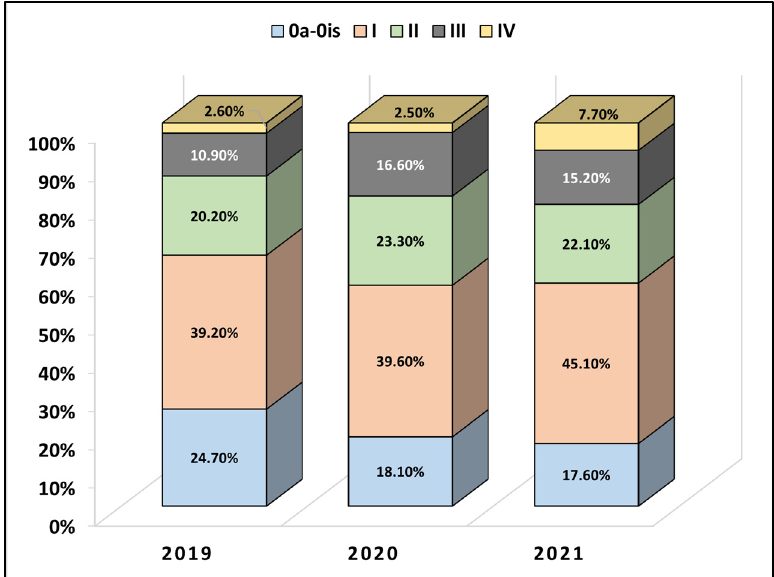
Figure 2. Comparative analysis of the TNM staging of urothelial carcinoma in patients receiving surgery before (2019) and during the SARS-CoV-2 pandemic